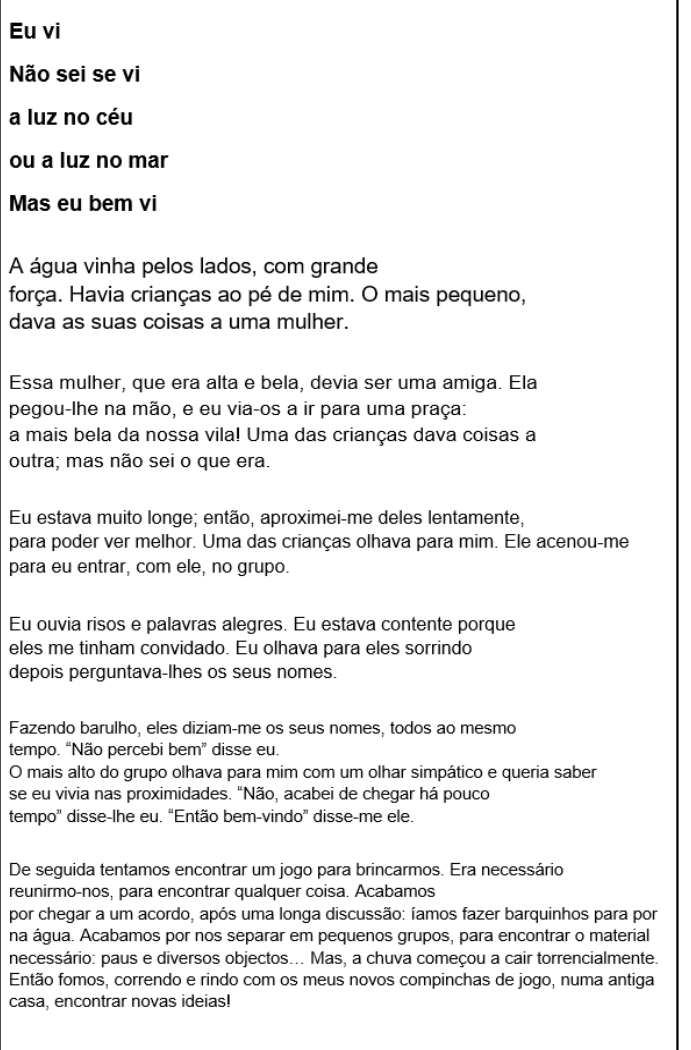
Figure 2. BHK text (Portuguese version obtained from the French version [15]—Figure A1 in Appendix A). Participants copied the BHK text, composed of progressively more complex words, for 5 min.